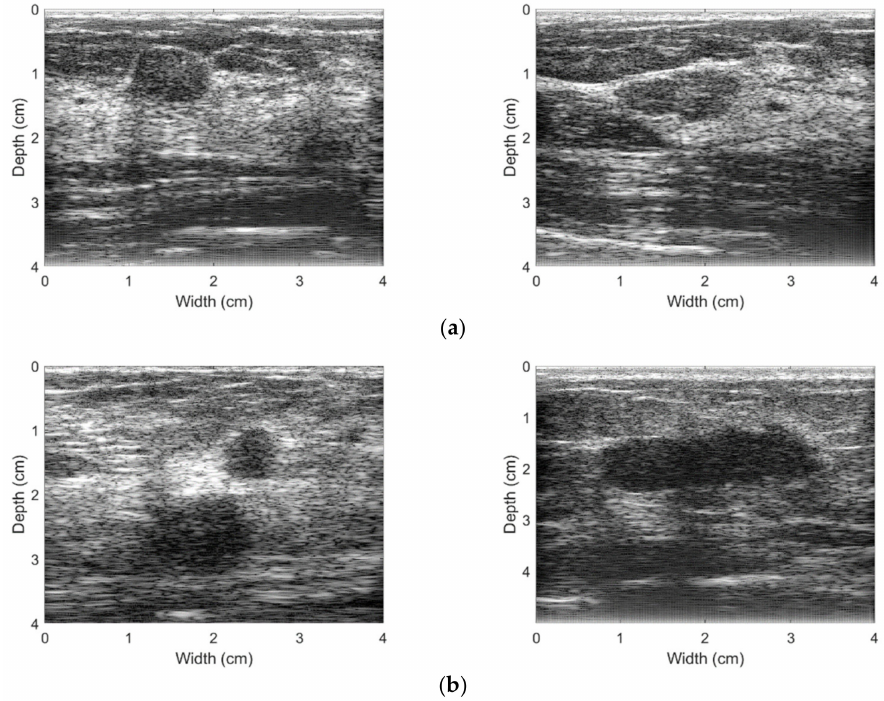
Figure 1. Sample B-mode images obtained from the radiofrequency (RF) signals of the open access series of breast ultrasonic data (OASBUD) dataset. ( a ) Benign lesions; ( b ) Malignant